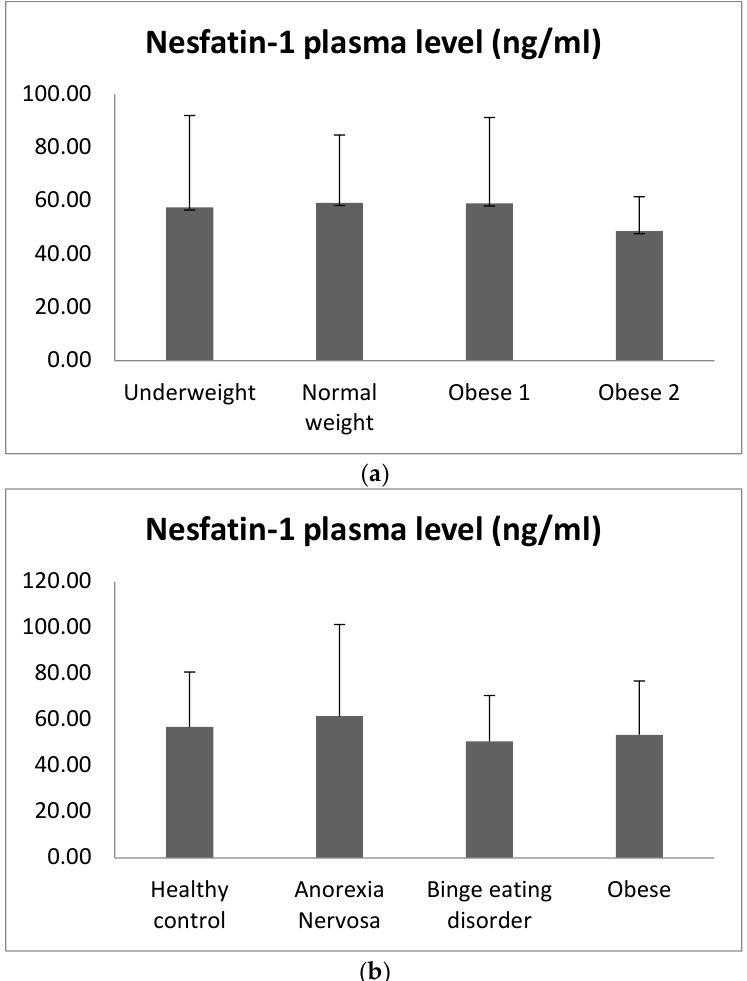
Figure 3. ( a ) Nesfatin-1 plasma levels according to BMI categories; ( b ) Nesfatin-1 serum levels according to EDs diagnosis.